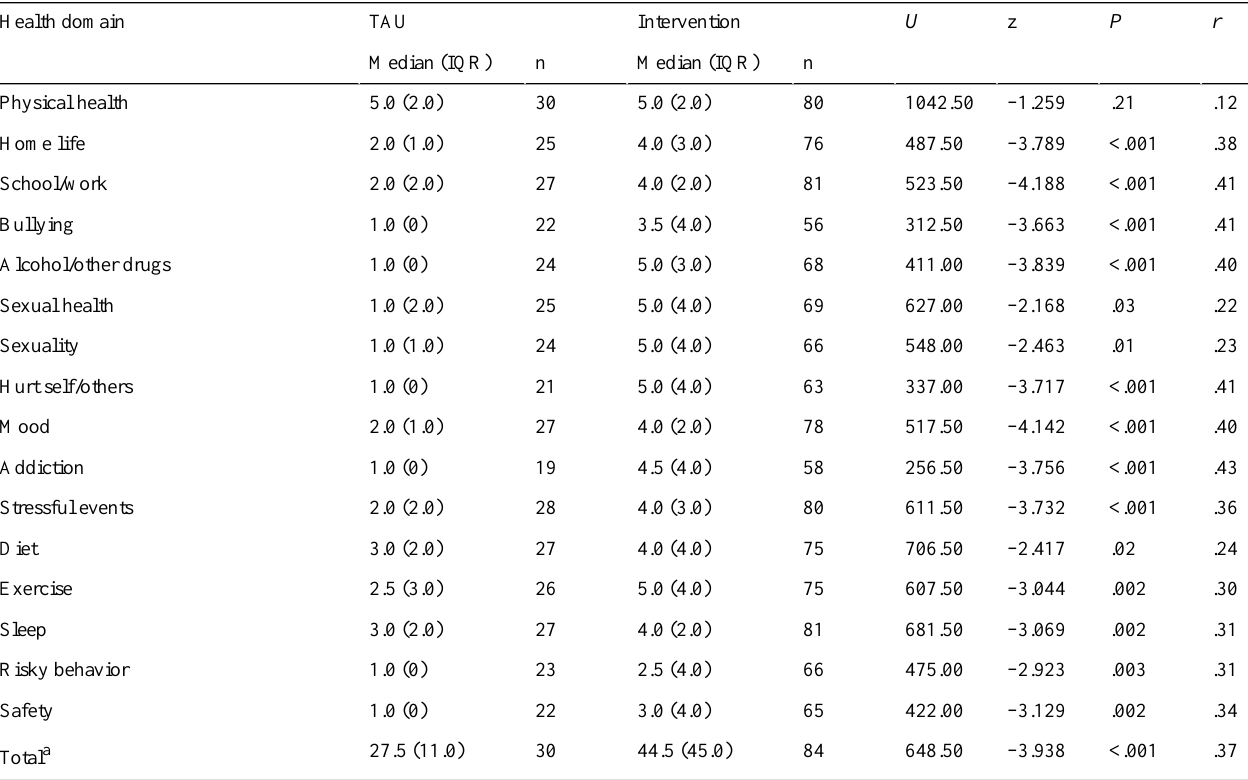
Table 5. Youth disclosure ratings of health and lifestyle issues in the treatment-as-usual (TAU) and intervention